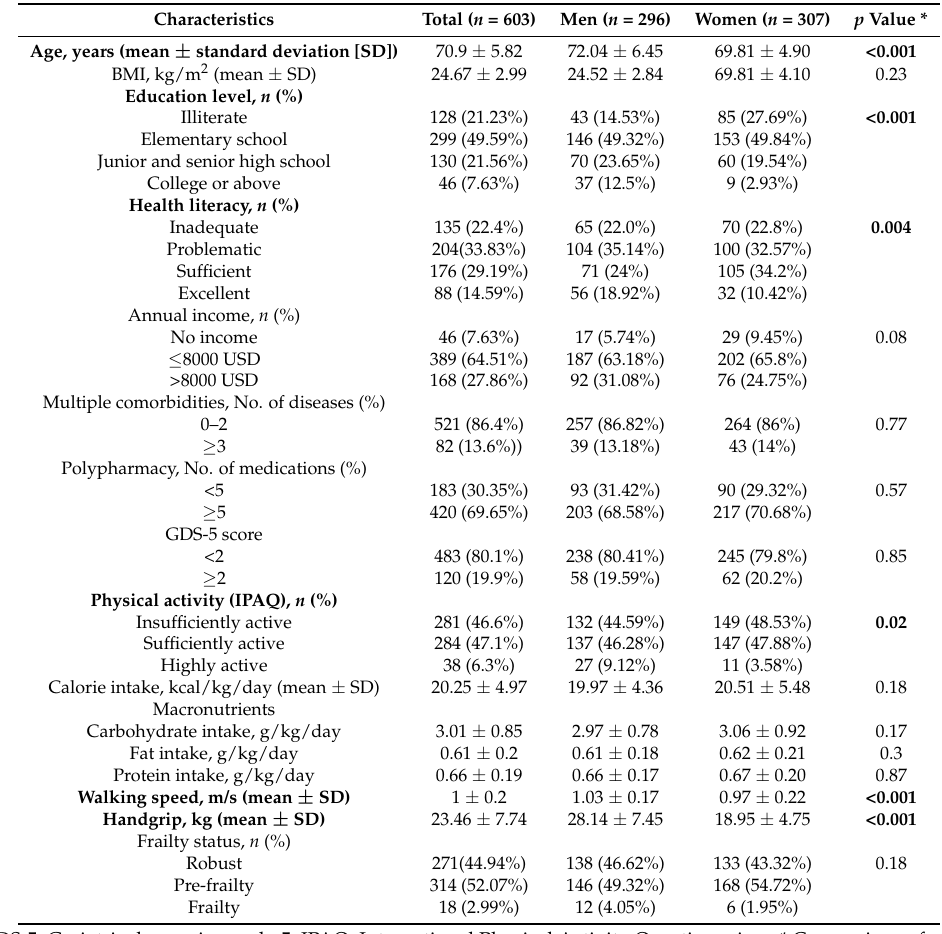
Table 1. Characteristics of the participants by sex Characteristics